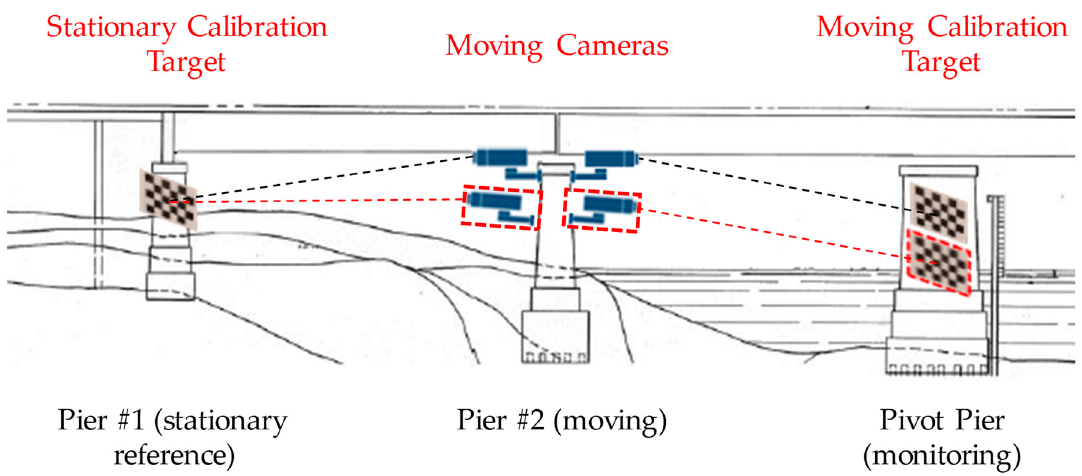
Figure 1. The overview of the proposed HIVBDM system in monitoring a swing bridge pivot pier. A stationary calibration target is mounted to the stationary reference pier, #1. The movements of the cameras and the moving calibration target are subject to the moving pier, #2, and the pivot pier, respectively. We assume that there is no relative movement between the two installed cameras.